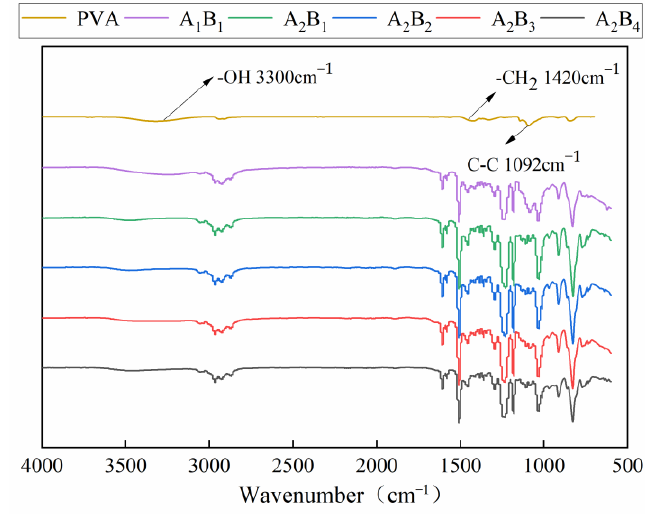
Figure 5. IR spectra of membrane materials under different ratios.